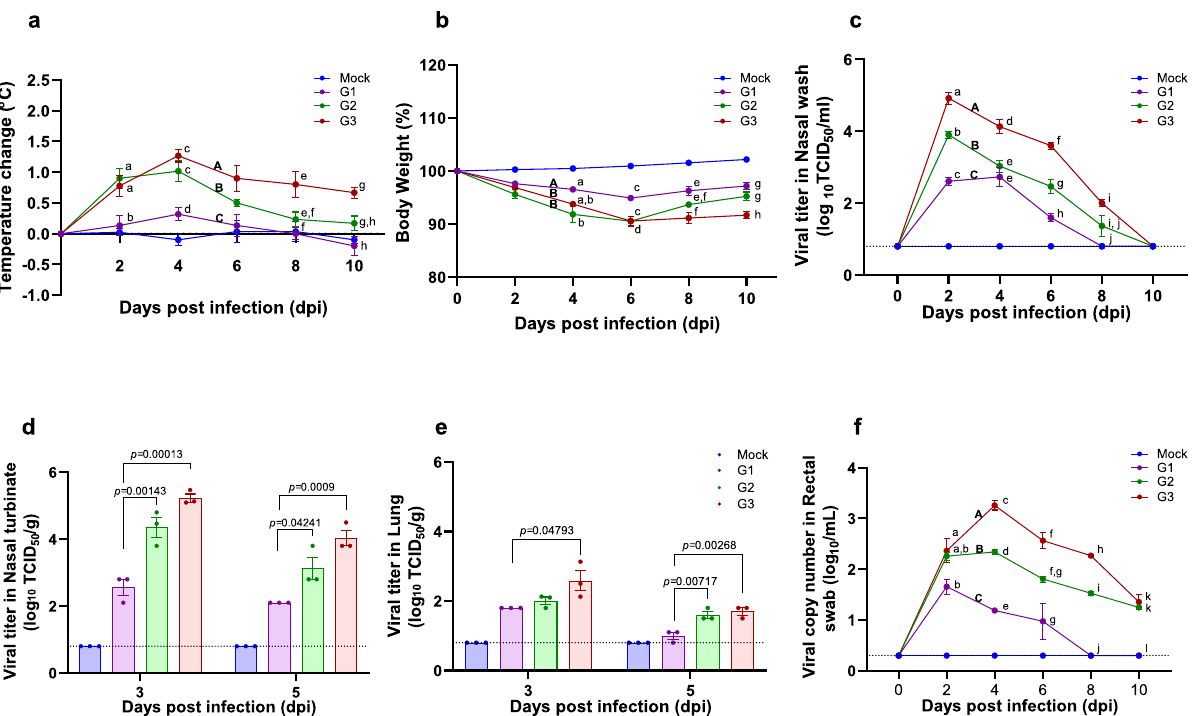
Fig. 2 Pathogenicity of SARS-CoV-2 infection among different ages of ferrets. Groups of ferrets [under 6 months (G1), one to two years old (G2), and more than three years old (G3); n = 9 per group] were inoculated with 10 5.8 TCID 50 of NMC-nCoV02 strain by the intranasal route. All groups were observed for morbidity and mortality for 10 days. The temperature change ( a ) and weight loss ( b ) were monitored. To compare virus growth in respiratory tracts, nasal washes ( c ) were collected at 0, 2, 4, 6, 8, and 10 dpi. Nasal turbinate ( d ) and lung ( e ) tissues were collected to recover infectious virus from infected ferrets ( n = 3) at 3 and 5 dpi. To compare virus growth in gastrointestinal tracts, rectal swabs ( f ) were collected at 0, 2, 4, 6, 8, and 10 dpi. Infectious viral titers in nasal washes and tissue specimens ( c , d and e ) were measured in Vero Cells, and viral RNA copy numbers in rectal swabs were quantitated using real-time PCR ( f ). Data are presented as mean values ± SEM. Groups with the same letter are of the same subgroup in the post-hoc analysis. Lower case letters indicate signi fi cant differences at each time point ( P values are a vs b: 0.00398 or 0.02009, c vs d: 0.00335 or 0.00011, e vs f: 0.038 and g vs h: 0.0033 (a), a vs b: 0.00476, c vs d: 0.0045 or 0.0047, e vs f: 0.00807 and g vs h: 0.00207 or 0.02917 (b), a vs b: <0.0001, a vs c: <0.0001, b vs c: <0.0001, d vs e: 0.00017 or 0.00247, f vs g: 0.0011, f vs h: <0.0001, g vs h: 0.0067 and i vs j: 0.0038 (c), a vs b: 0.015, c vs d: <0.0001,